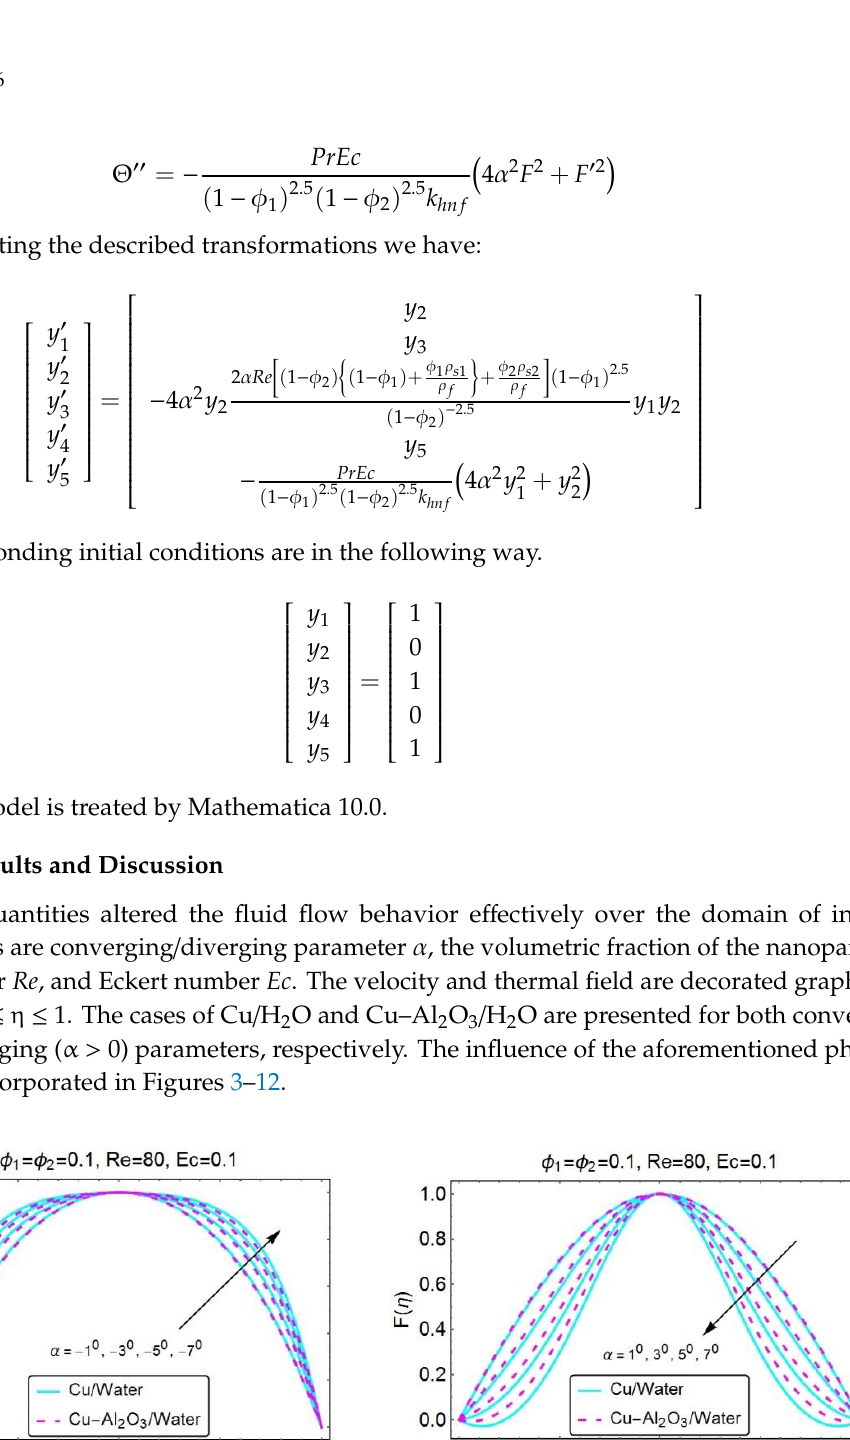
Figure 4. Stimulus of ϕ 2 on F(η) : ( a ) convergent case and ( b ) divergent channel. ( a ) ( b ) Figure 5. Stimulus of Re on F(η) : ( a ) convergent case and ( b ) divergent channel. The effects of α , Eckert number, and Reynold’s number are shown in Figures 6–9. Figure 6 investigates the opposite behavior of the thermal field. It is clear that for negative α , fluid temperature decreases in the region −0.5 ≤ η ≤ 0 and in 0 ≤ η ≤ 0.5, the temperature profile starts decelerating. In the case of Cu/water, rapid reduction in the temperature occurs. The reverse alterations are examined from −1.0 ≤ η ≤ −0.5 and 0.5 ≤ η ≤ 1.0. On the other hand, the opening channel favors the fluid temperature. The temperature of Cu–Al 2 O 3 /H 2 O increases very rapidly. In addition, the thermal field of water containing copper nanoparticles increases, but upturns in the temperature are quite slow in